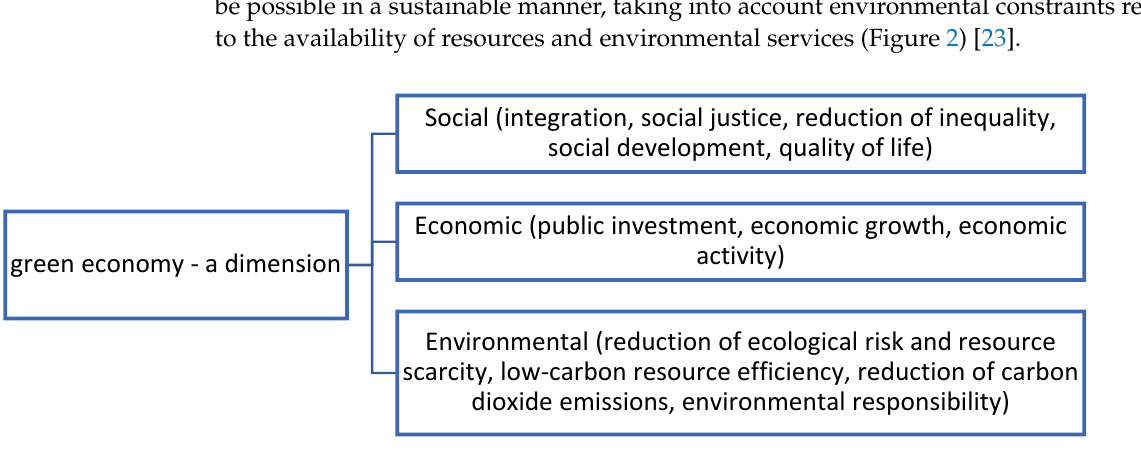
Figure 2. Dimensions of the green economy. Source: study based on B. Ryszkowska, Green economy—theoretical foundations of the concept and measurement of its implementation in the European Union, Ed. UE in Wroc ł aw, Wroc ł aw 2013.